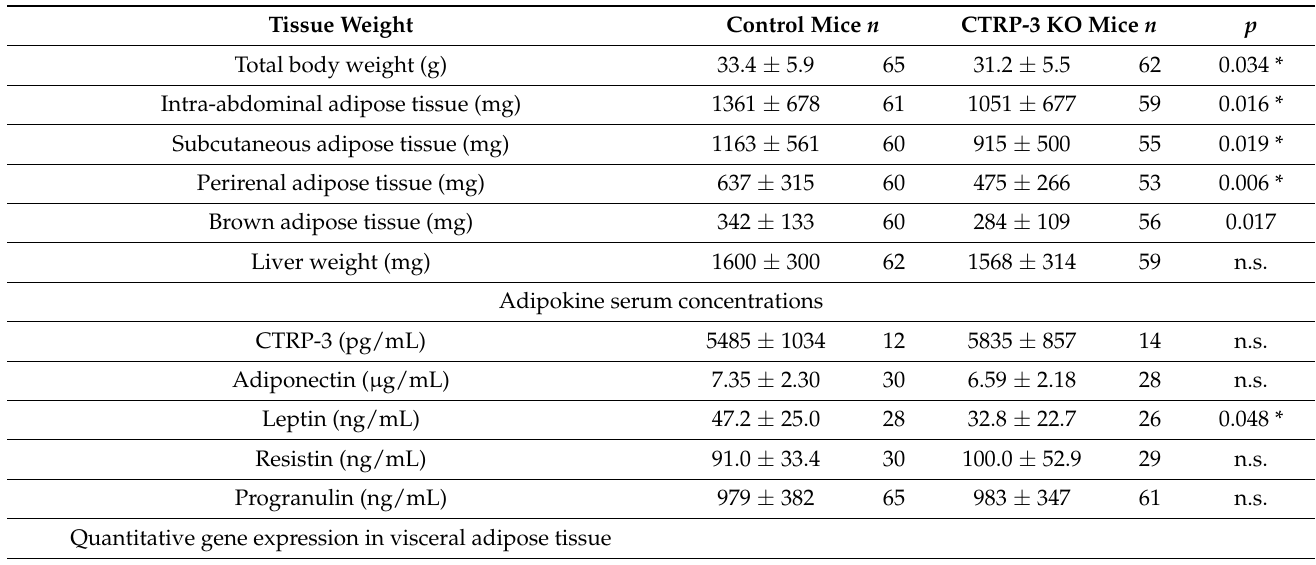
Table 1. Tissue weights, adipokine serum concentrations, and visceral adipose tissue gene expression profiles in control vs. CTRP-3 knockout